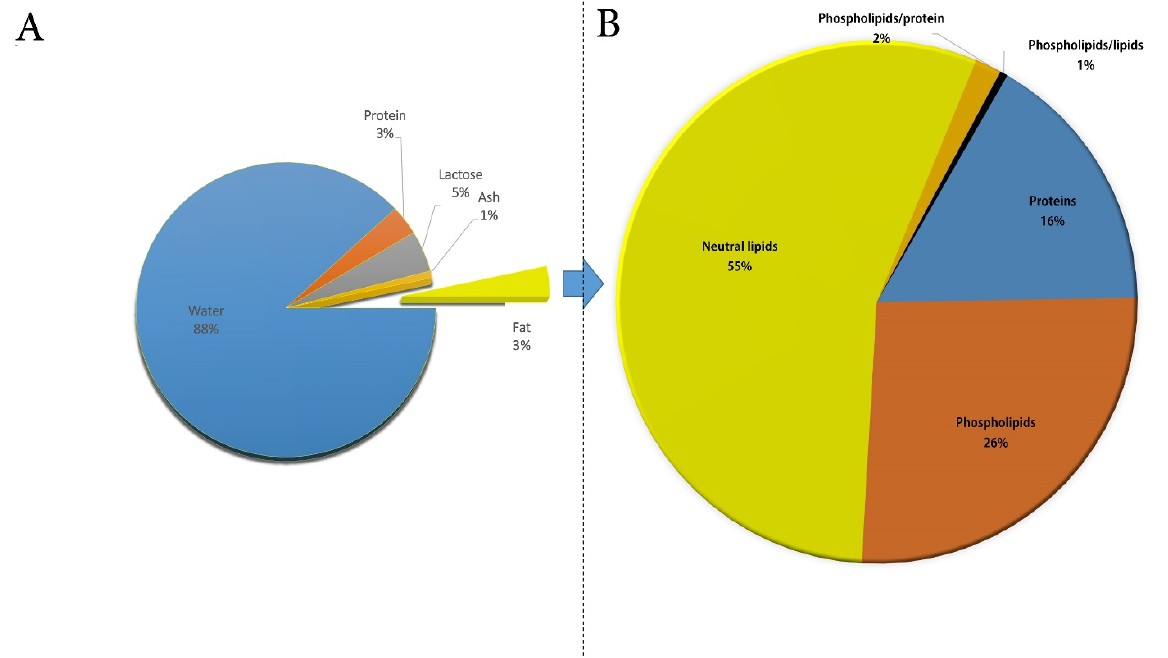
Figure 1. ( A ) Chemical composition of camel milk. ( B ) Composition of milk fat globule membrane in camel milk. The charts were created considering the data reported in Ref. [9] ( A ) and [29] ( B ).